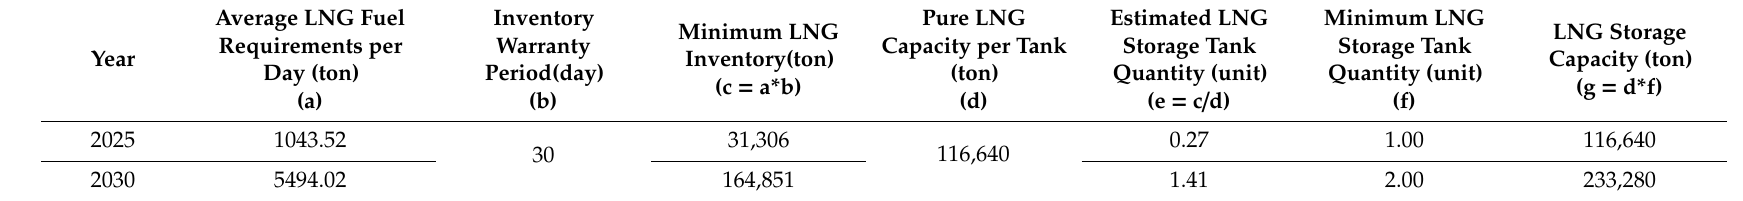
Table A7. Required LNG Storage Tank.